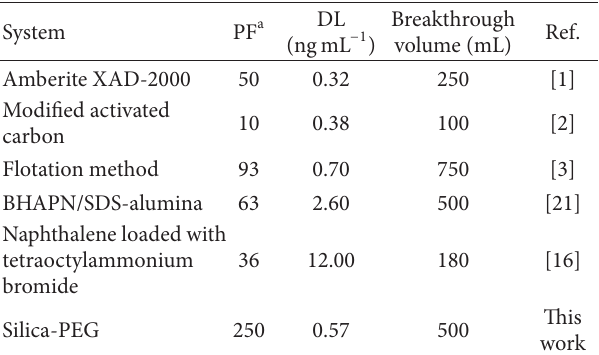
T 4: Comparison of the proposed method with some of the methods reported in